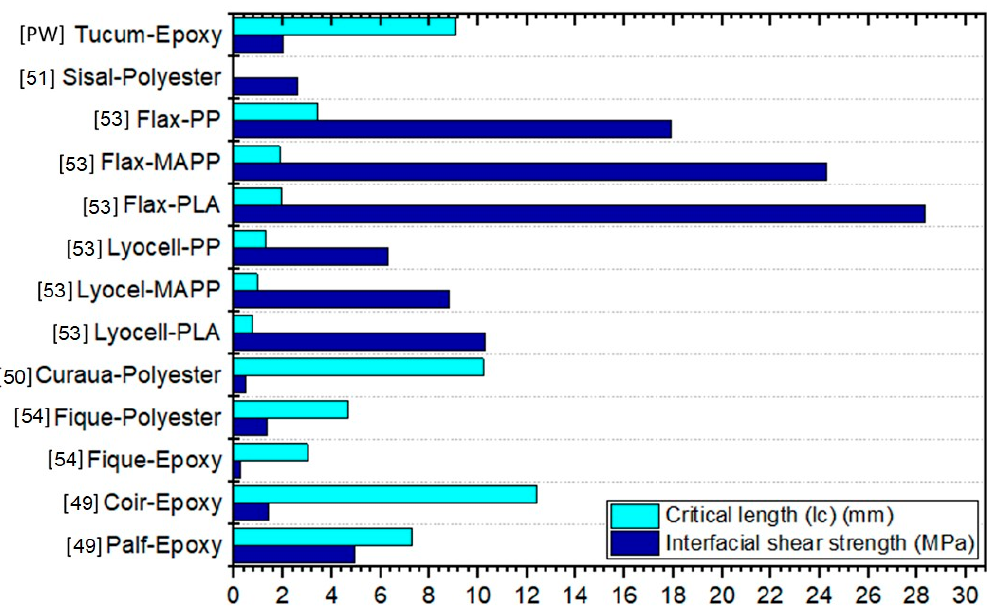
Figure 7. Comparison of pullout tests of different natural fibers/polymer. Palf-epoxy and coir-epoxy [49]; lyocell-PLA, lyocel-MAPP, lyocell-PP, flax-PLA, flax-MAPP, flax-PP [53]; sisal-polyester [51]; curaua-polyester [50], fique-epoxy and fique-polyester [54]; tucum-epoxy (Present work (PW)).